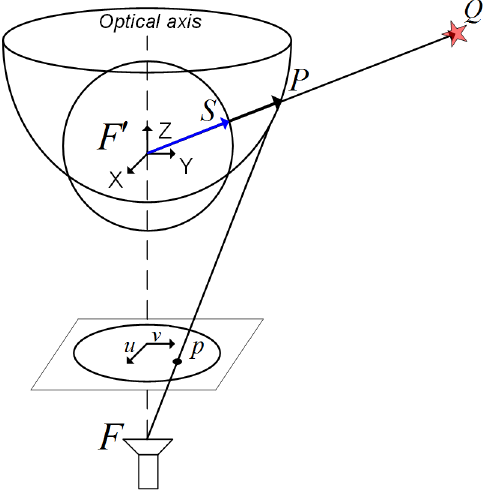
Figure 2. Omnidirectional camera 3D projection model from an XYZ